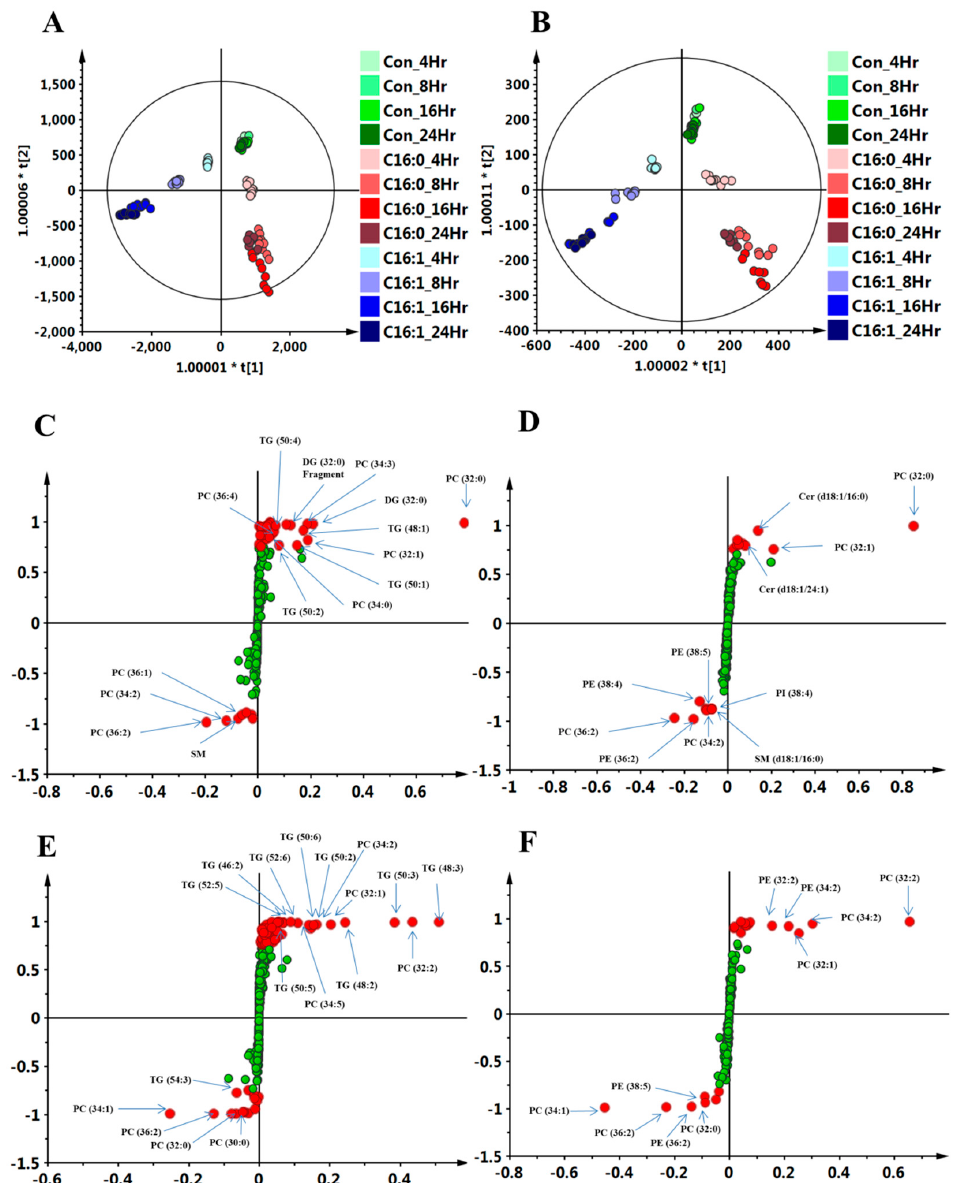
Figure 2. FFAs induced metabolic change in HepG2 cells performed by LC–TOFMS-based lipidomics analysis in ESI-positive and -negative modes. HepG2 cells treated with or without 0.3 mM palmitic acid (C16:0) or palmitoleic acid (C16:1) for 4, 8, 16, and 24 h were subjected to the modified Folch’s method for lipid extraction, followed by chromatography and TOF-MS analysis in ESI-positive and-negative modes. All molecular features of HepG2 cells ( n = 9 per group, biological triplicates and technical triplicates) were determined by the Progenesis QI software, and subsequently, data processing and statistical analysis were performed by SIMCA-P. The orthogonal partial least squares discriminant analysis (OPLS-DA) score plot was generated from all the hydrophobic metabolite profiles and depicted in panels ( A ) and ( B ), demonstrating positive and negative modes separately. The ellipse shown in the model represents Hotelling’s T2 test with 95% confidence interval. The data of control or C16:0- and C16:1-treated cells (16-h treatment) were re-analyzed using OPLS-DA, and the metabolites with a significant difference between the normal control and C16:0 or between the normal control and C16:1-treated cells were represented in S-plots ( C ) (C16:0, ESI-positive mode), ( D ) (C16:0, ESI-negative mode), ( E ) (C16:1, ESI-positive mode), and ( F ) (16:1, ESI-negative mode). The red points were marked as the significant metabolites in the realm, p (corr) > 0.75 and p (corr) < − 0.75, respectively.